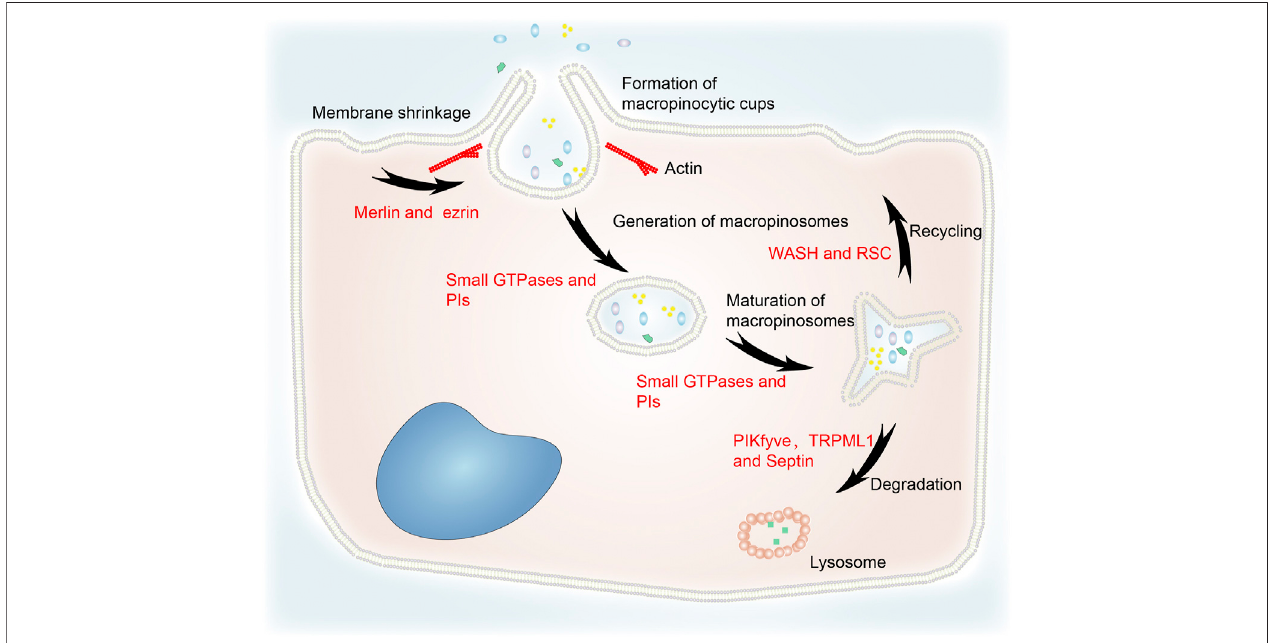
FIGURE1| Thegeneralprocessofmacropinocytosisincludingcytoplasmicmembraneshrinkage,formationofmacropinocyticcups,generationandmaturationof macropinosomes, fusion ofmacropinosomes and lysosomes, recycling, and degradation. Merlin and ezrin are involved in cytoskeleton remodeling. Small GTPases and PIs are essential for the generation and maturation of macropinosomes.WASH and RSC regulaterecycling to the cytoplasmicmembrane. PIKfyve, TRPML1 and septin are implicated in the degradation of macropinosomes via their fusion with lysosomes.